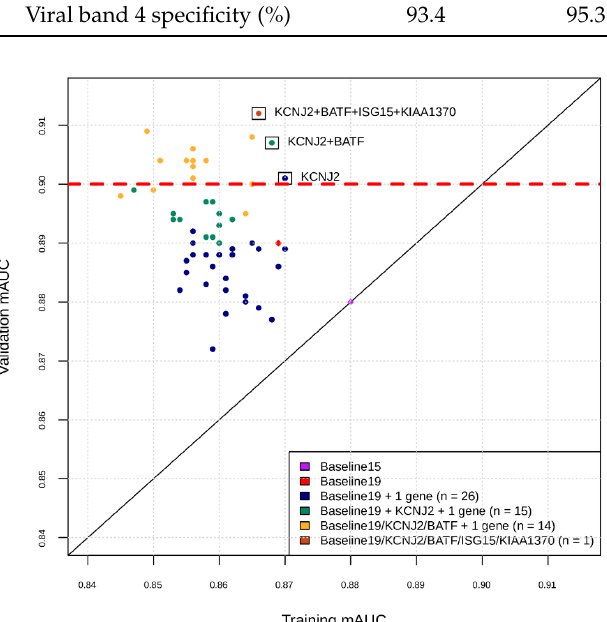
Figure 1. Intermediate snapshot of the Phase II of the marker selection by machine learning. X -axis is the cross-validation AUC in training for best model found by Bayesian Hyperparameter Optimization using features comprising current marker set plus one marker at a time. Y -axis is the AUC of that model applied to validation set. For example, the blue dots represent training and validation AUCs for feature sets consisting of the 19 markers found in Phase I, plus one of the markers in the remaining set of markers. KCNJ2 was added to current marker set and the process repeated for the remaining set of markers (green dots), etc.